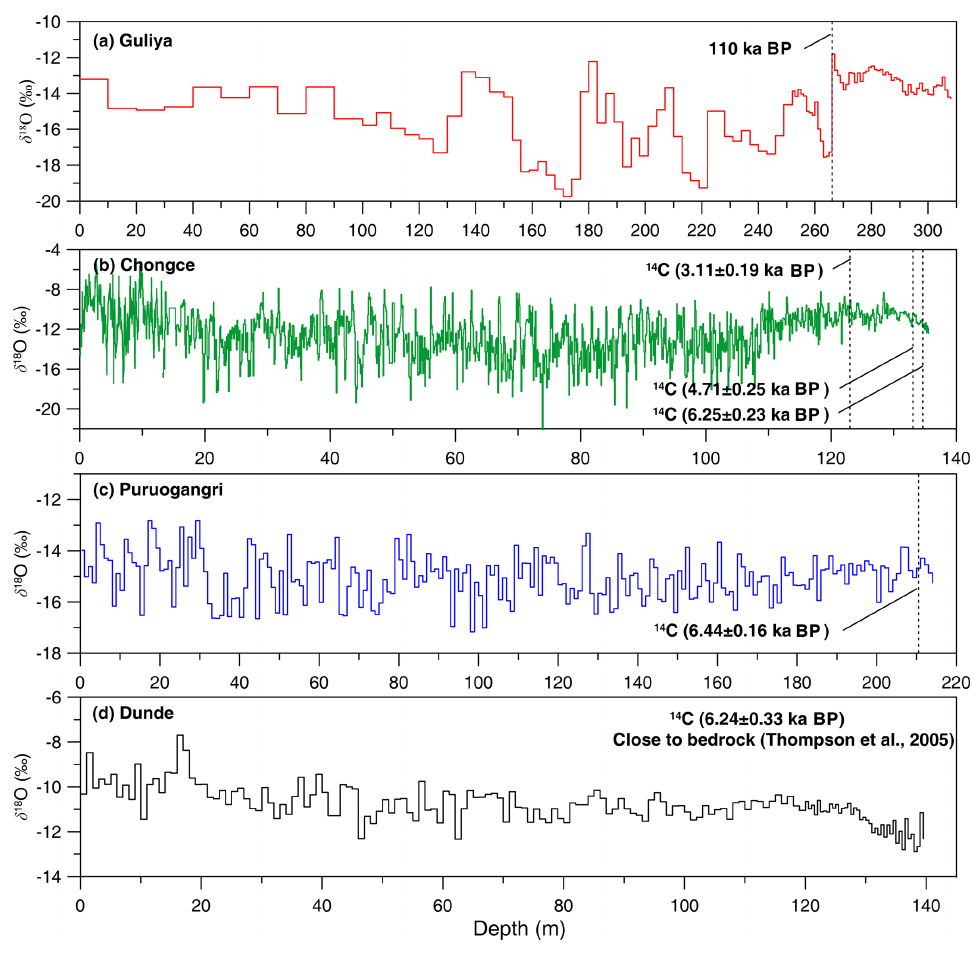
Figure 2. The δ 18 O profiles of the ice cores against each respective depth. The age of 110kaBP at the depth 266m of the Guliya ice core is from Thompson et al. (1997). The top 13.2m of Chongce Core 3 profile (An et al., 2016) is combined with Core 2 to form a single profile because the distance between their drilling sites is only ∼ 2m (Fig. 1). Data of Guliya and Puruogangri were obtained from the NOAA online repository, and the data of Dunde were extracted from the Fig. 3 in Thompson et al. (1989) using GetData graph digitizer